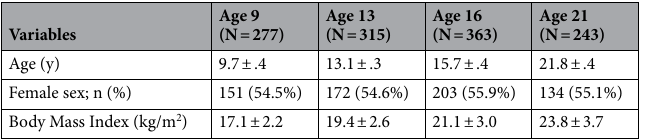
Table 1. Descriptive baseline and follow-up demographic information a . a All values are reported as mean ± standard deviation.